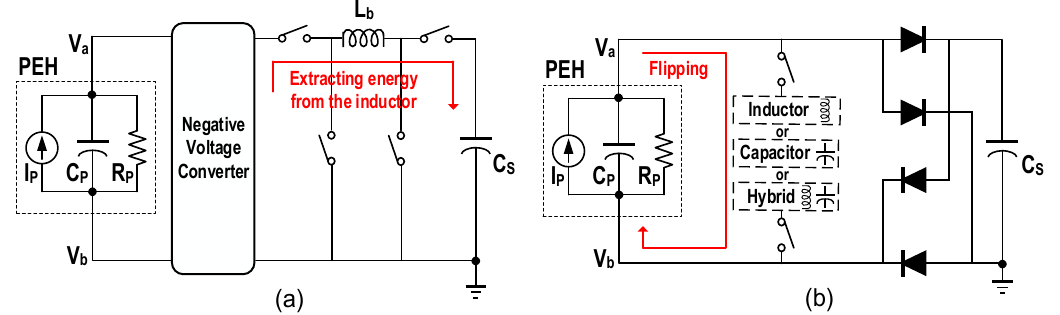
Figure 10. Interface circuit architecture diagrams of ( a ) the SECE, ( b ) the SSH. On the basis of the multiple extraction and the pre-charge techniques, the multiple charge extraction with bias-flip (MCEBF) was proposed [30], which flipped the residual voltage after completing multiple extraction. Apparently, the conduction losses during pre-charge process can also be reduced by transfer the energy multiple times. Moreover, the extent of pre-charge has the effect on the increase in the output power. Therefore, the multiple charge extractions and multiple pre-charge (MCE-MPC) was proposed [31] to further improve the output capacity of the system. It utilized the energy of C S for pre- charge, which enabled the multiple transfer and precise control of the pre-charge energy. The simulation results shown the output power of the MCE-MPC was increased by 101.92%, 24.60%, and 7.62% compared with the SECE, MCE, and MCE-MPC, respectively. Figure 11 depicts their energy transfer paths, the waveforms of V P , I P and the inductor current i L for demonstration.